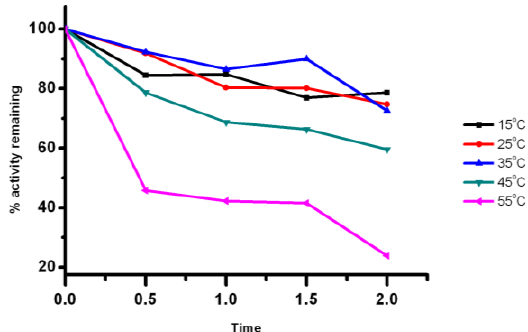
Figure 5. Effect of temperature on the recombinant lipase thermostability. The enzyme was assayed after incubation in a range of temperatures (15–55 °C) for 2 h. Activities are displayed as percentages of the initial activity (31.27